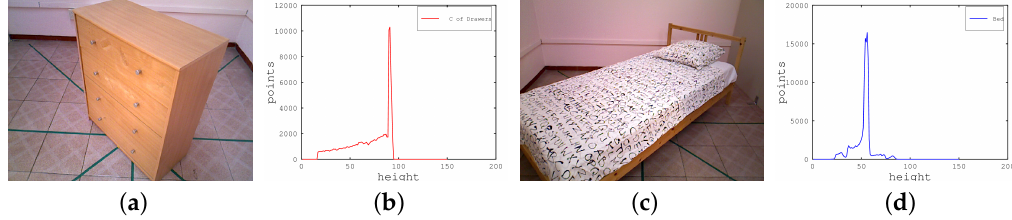
Figure 6. Example of a height histogram of two different pieces of furniture. In ( a ), the RGB image of a chest of drawers, and in ( b ), its height histogram. In ( c , d ), the RGB image of a bed and its height histogram, respectively.